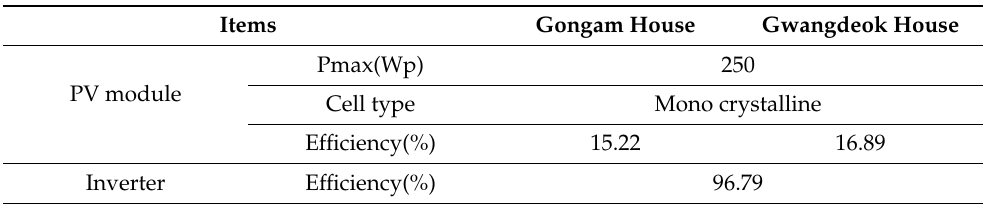
Table 3. PV system specifications.